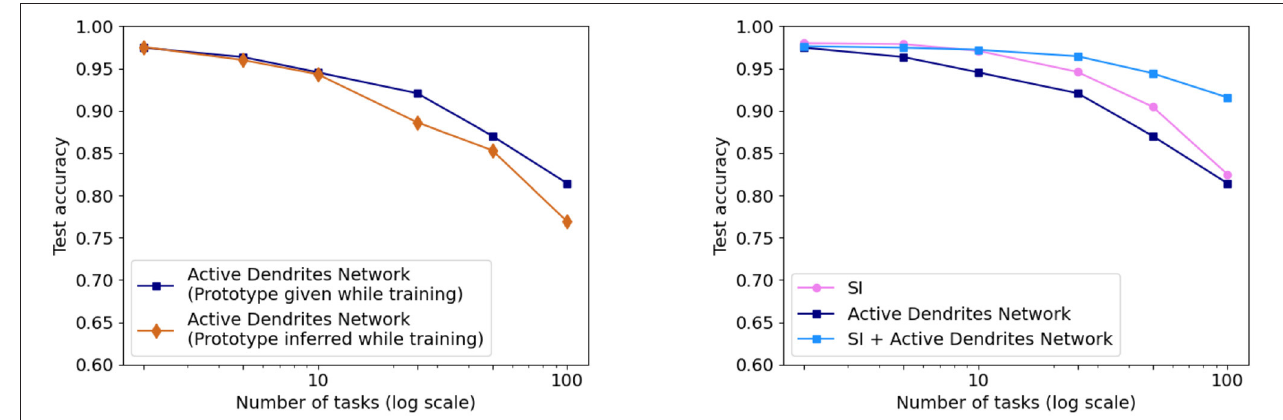
FIGURE 8 | (Left) The accuracy of our Active Dendrites Networks when learning 2, 5, 10, 25, 50, and 100 permutedMNIST tasks in sequence. We show results using both prototype methods while training: when the model is provided with a prototype, and when it must select the vector in an online manner. (Right) The accuracy of the Active Dendrites Network and SI. The accuracy when combining SI + active dendrites is greater than either one on its